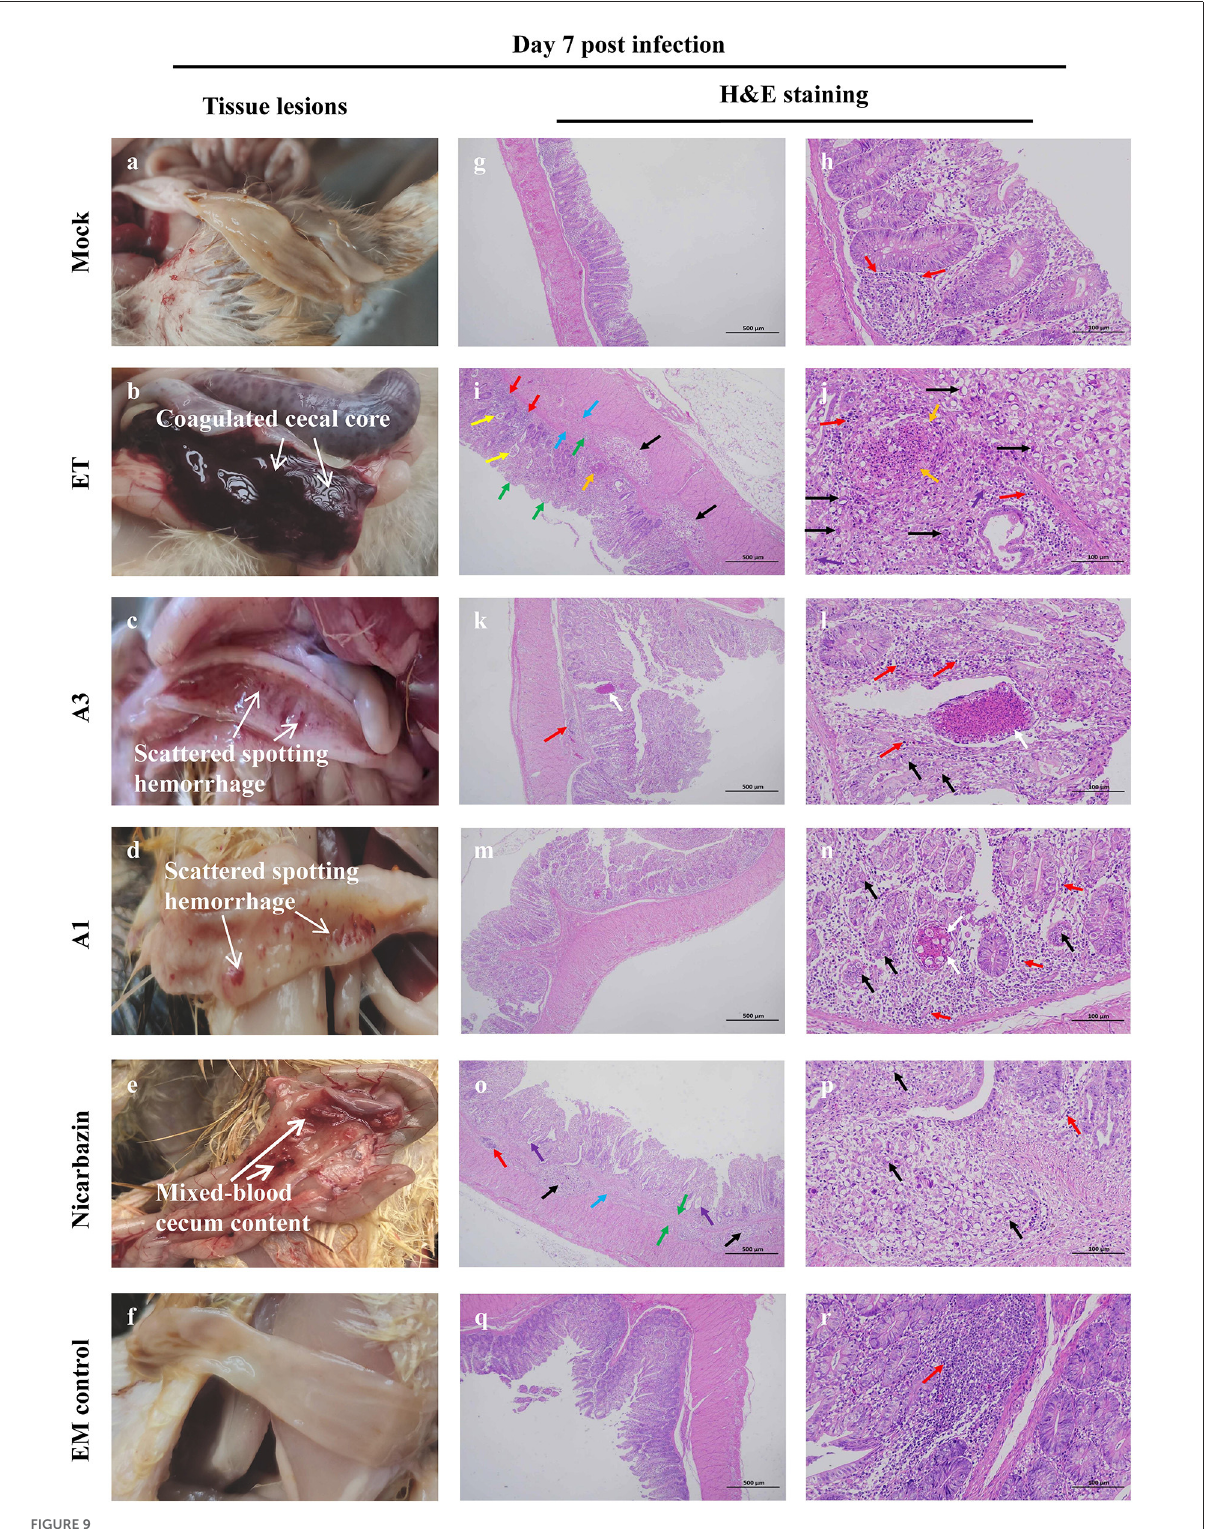
FIGURE9 Macroscopic lesions and histopathology of the cecum from chickens administered EM on Day 7 p.i. Macroscopic cecal lesions in the (a) mock, (b) ET, (c) A3, (d) A1, (e) nicarbazin, and (f) EM control groups. Arrows indicate characteristic lesions. Histopathological sections (two panels for each group [representing the same sample at different scales]) of the cecum in the (g,h) mock, (i,j) ET, (k,l) A3, (m,n) A1, (o,p) nicarbazin, and (q,r)